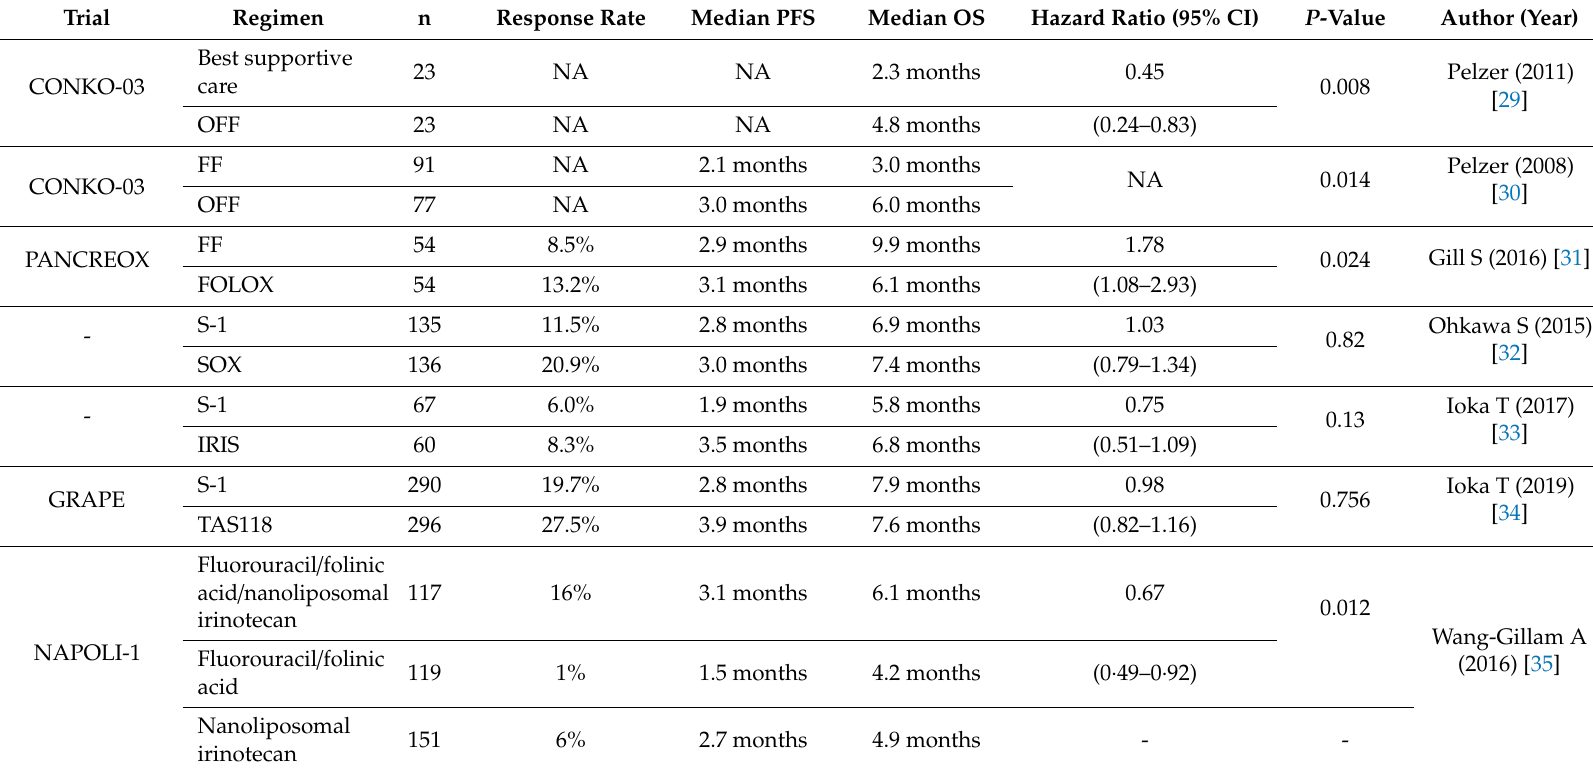
Table 3. Clinical trials of second-line chemotherapy for pancreatic